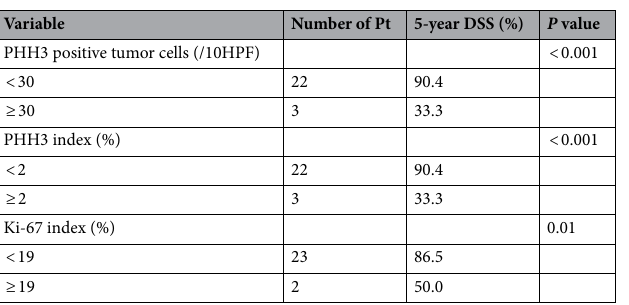
Table 3. Disease-specific survival rate using the Kaplan–Meier method and univariate analysis using the log- rank test. PHH3 Phosphohistone H3, HPF High power fields.